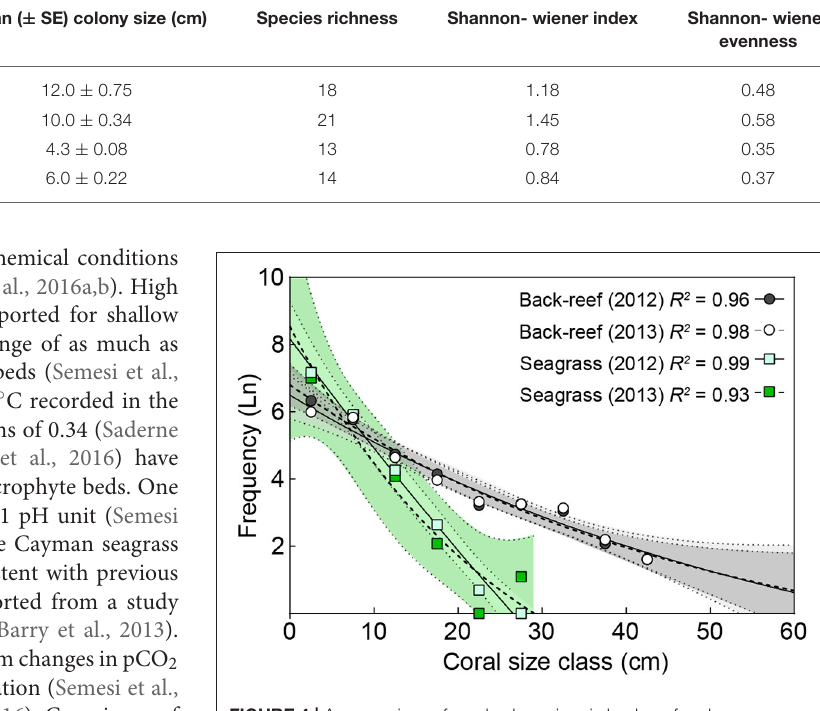
FIGURE 4 | A comparison of coral colony sizes in back-reef and seagrass habitats. Exponential decay model of coral colony size vs. the natural log (Ln) of the frequency of corals within each size class for 2012 (solid lines) and 2013 (hashed lines) in back-reef (circles) and seagrass (squares) habitats. Data are pooled across study sites ( n = 3) and 95% confidence bands of each model are shown by areas colored corresponding to symbol